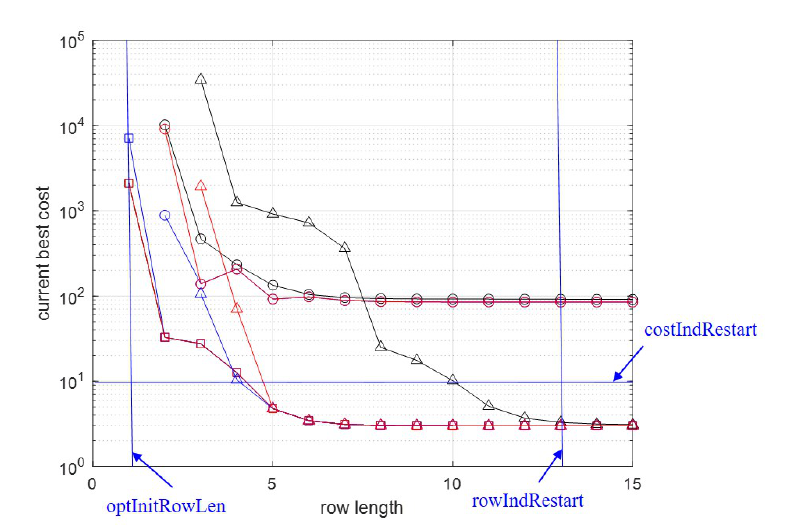
Figure 6. Preparatory search result and the three escaping indices for the Goldstein–Price function.